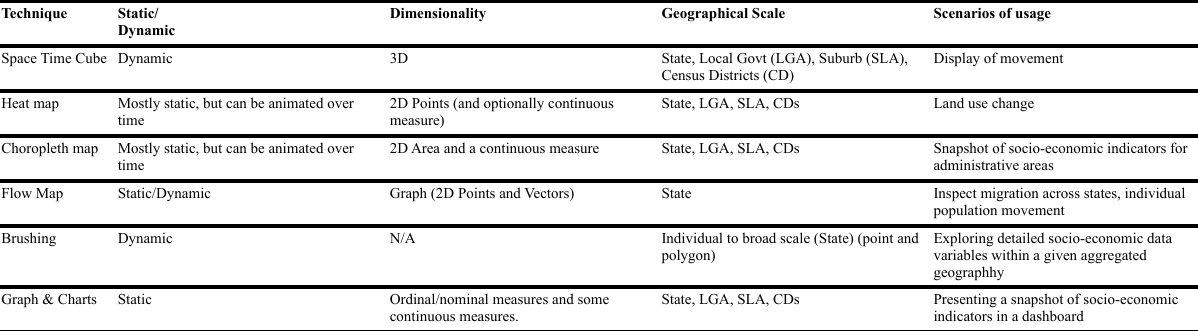
Table 1. Summary of visualisation techniques relevant to AURIN